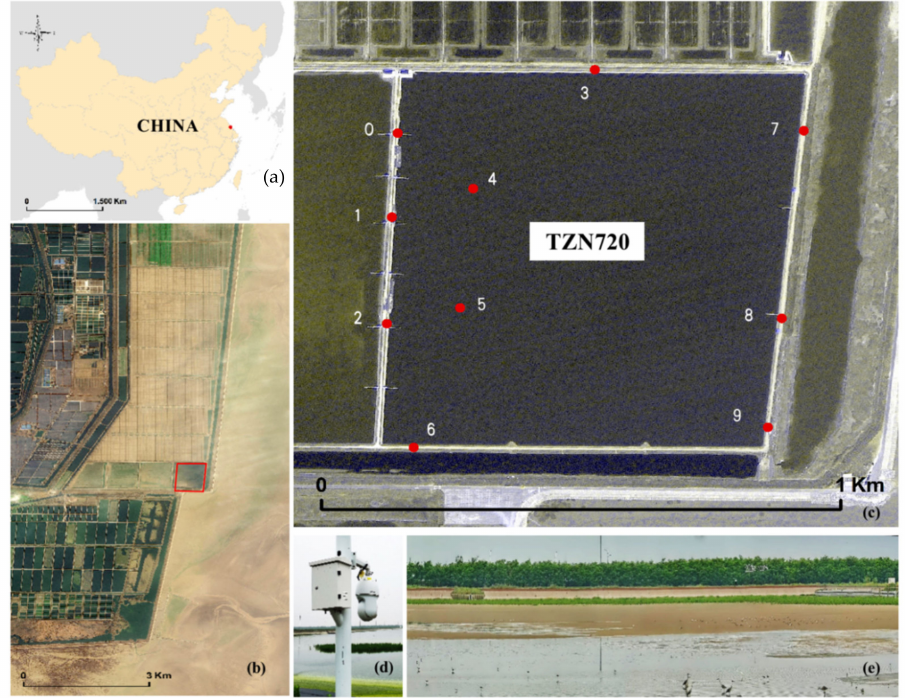
Figure 1. Overview of the Tiaozini wetland. The red point in ( a ) is a key staging site for migratory waterbirds, located in the east coast of Dongtai City, Jiangsu Province, China. The study site TZN720, the red square in ( b ), is a restored wetland and the monitoring site within the Tiaozini wetland; the red dots in ( c ) show the location of the 10 surveillance cameras; ( d ) shows the setup of a surveillance camera; and ( e ) is a panoramic view of TZN720 obtained from the